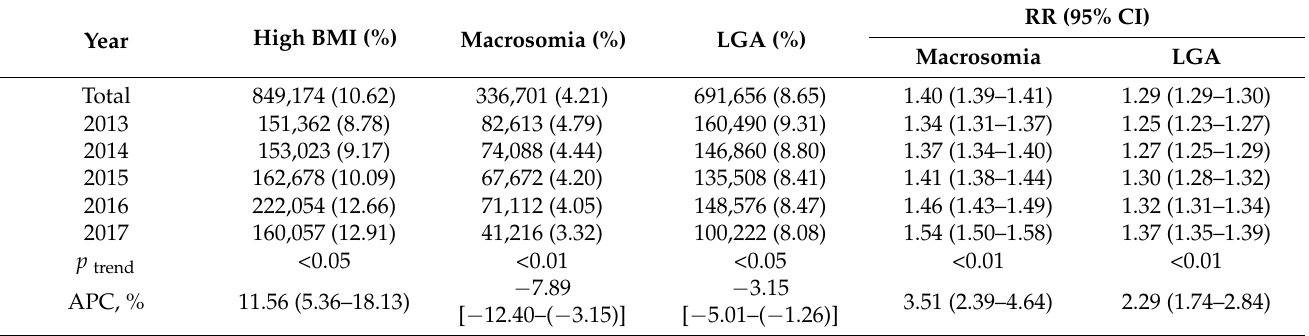
Table 2. Proportions of exposure and outcomes and their relative risks across LMP